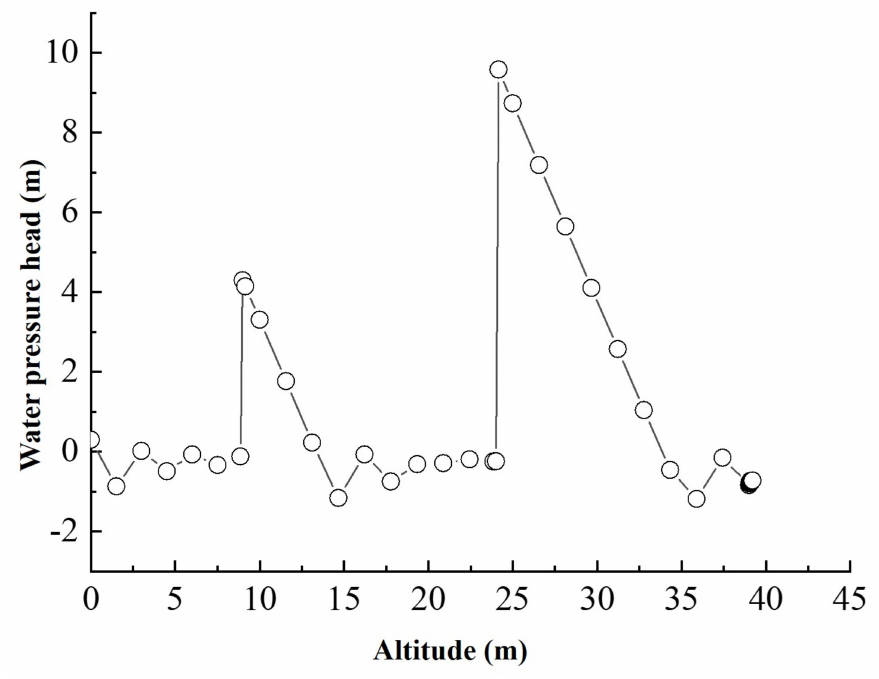
Figure 8. The relationship between water pressure head and landfill depth.